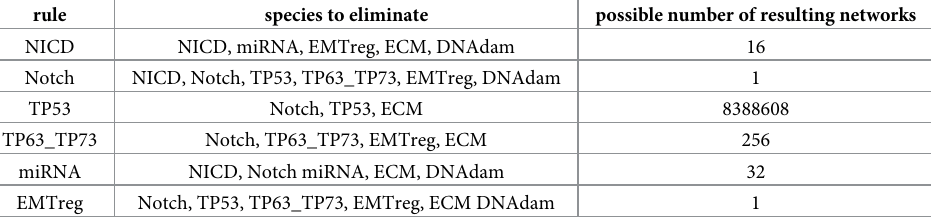
Table 7. Overview of model selection for the expert knowledge guided variant. The numbers are obtained using Algorithm 1, starting with the transition list of the full backwards model and removing every possible combination of the elimination of self reference by brute